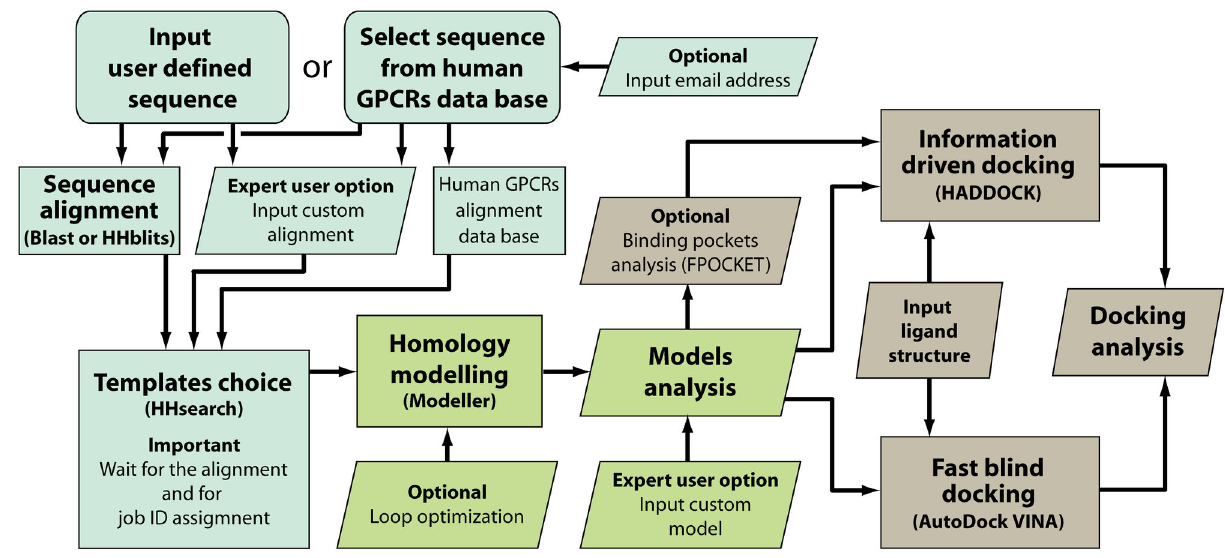
Figure 1. GOMoDo flow chart colored accordingly to the pipeline section. Alignment and template choice, homology modeling and model assessment, and docking sections are reported as light blue, light green and gray,